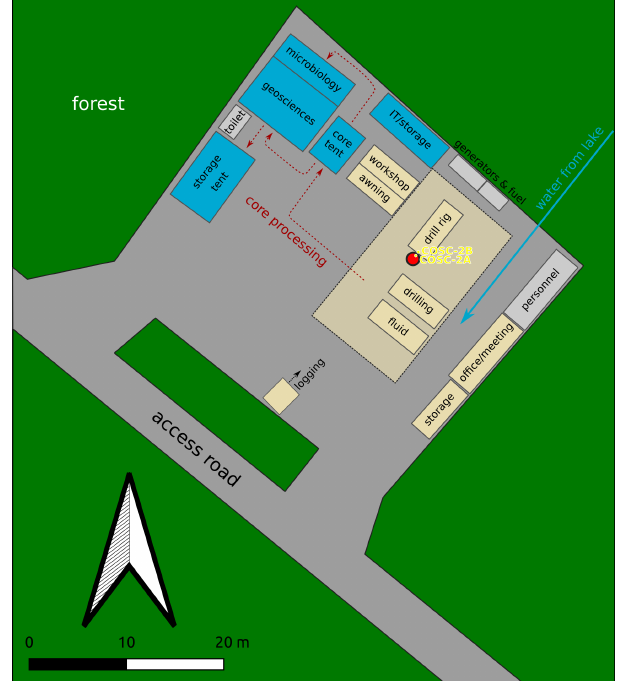
Figure 3. Sketch of the COSC-2 drill site. The area is approxi- mately 1600m 2 large, with the northwestern half used for the sci- ence operations (blue), parking, and storage and the southeastern half used for the technical operations (yellow) and common facili- ties. The route of the core from drilling deck to storage is marked in